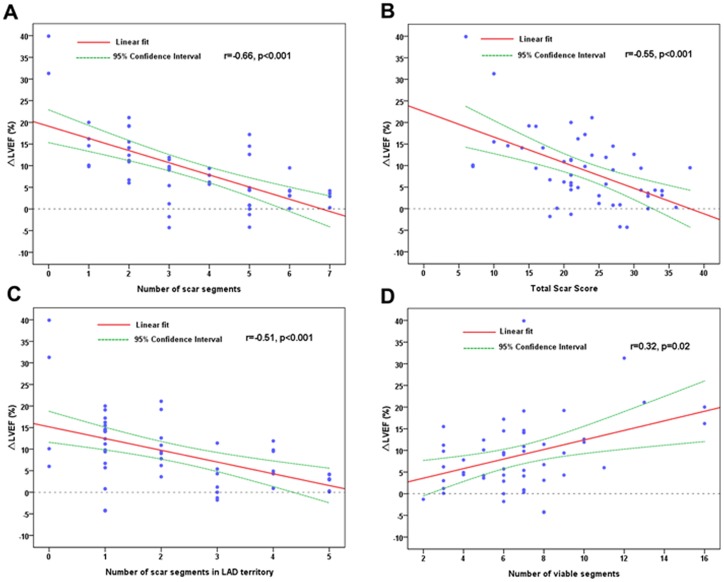
The Association Between Myocardial Viability and Change in LVEF.Scatter plot showing the linear association between the number of scar segments(A), total scar score(B), the number of scar segments in LAD territory(C), the number of viable segments(D) and change in LVEF (ΔLVEF) at 6 months post-surgery. LAD, left anterior descending coronary artery. LVEF, left ventricular ejection fraction.